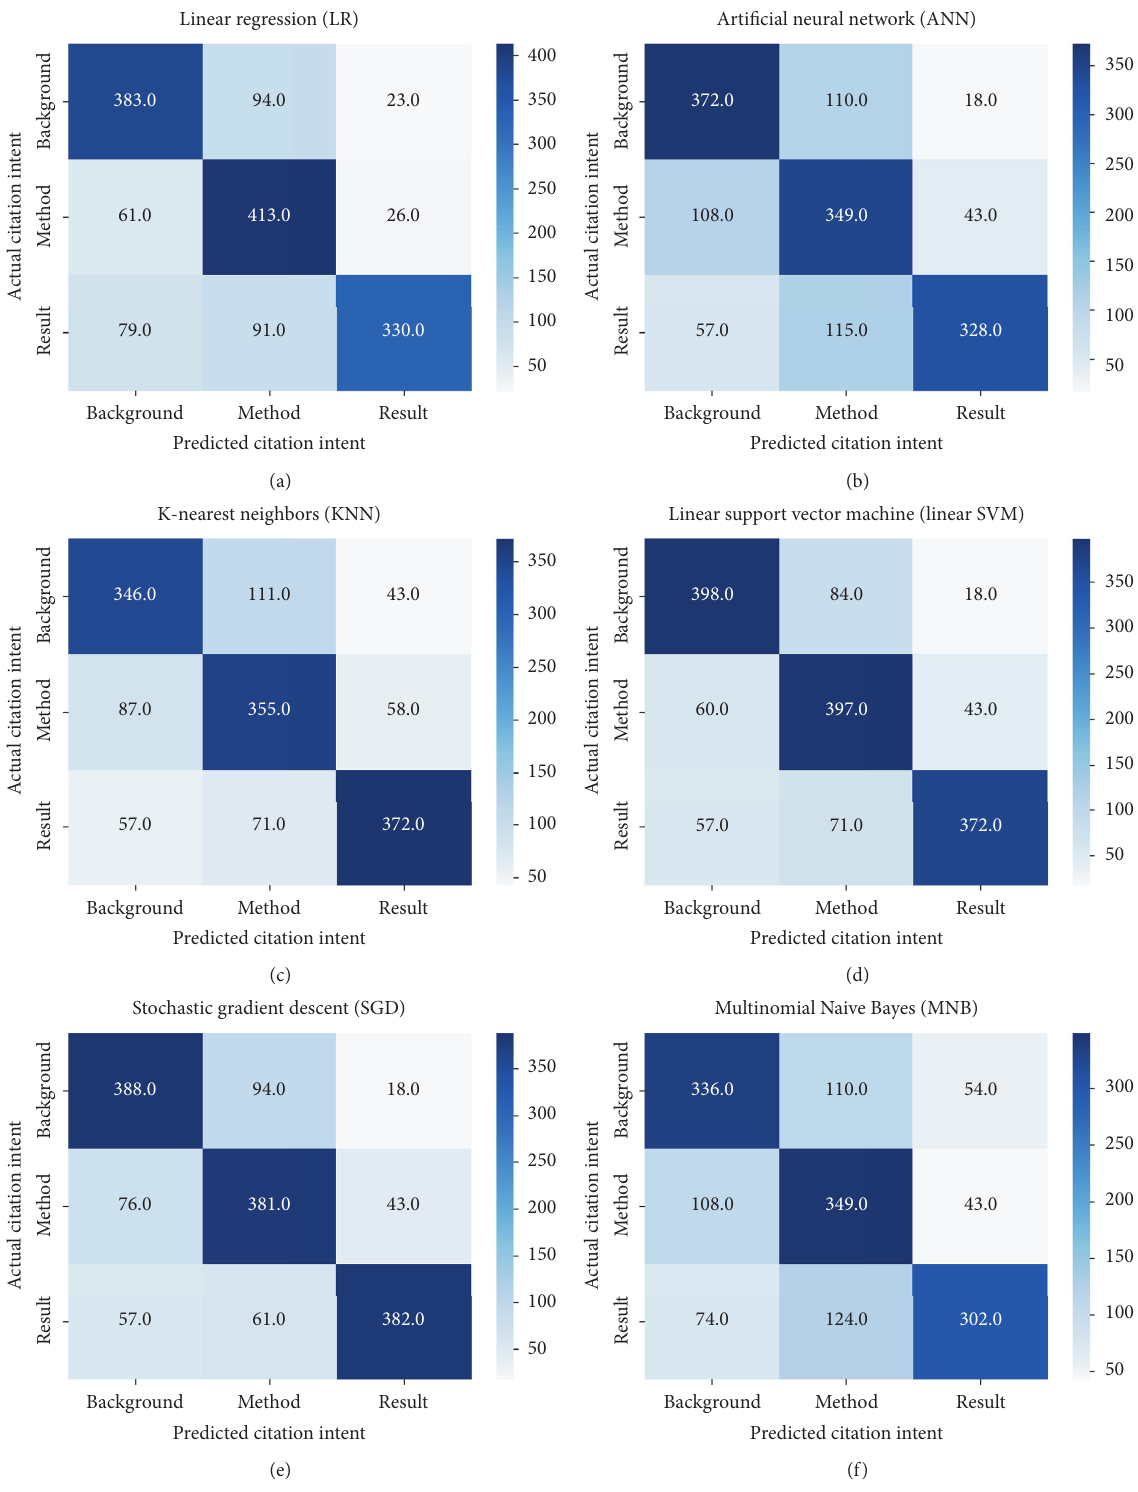
Figure 5: Multiclass confusion matrix using the balanced SciCite dataset for each